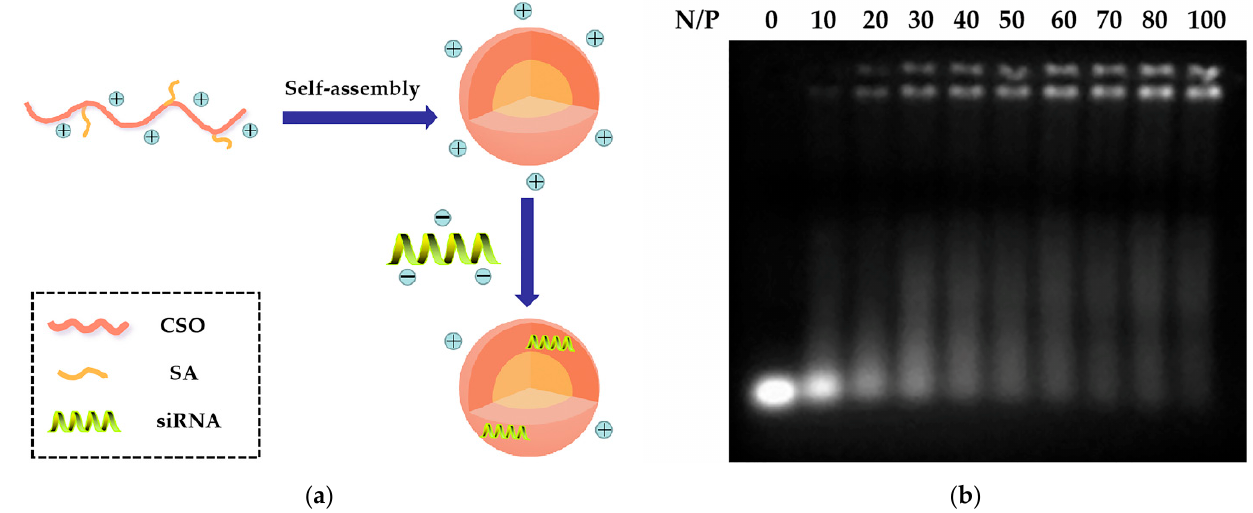
Figure 2. Preparation of CSSA/siRNA. ( a ) The schematic diagram; ( b ) Gel retarding analysis.